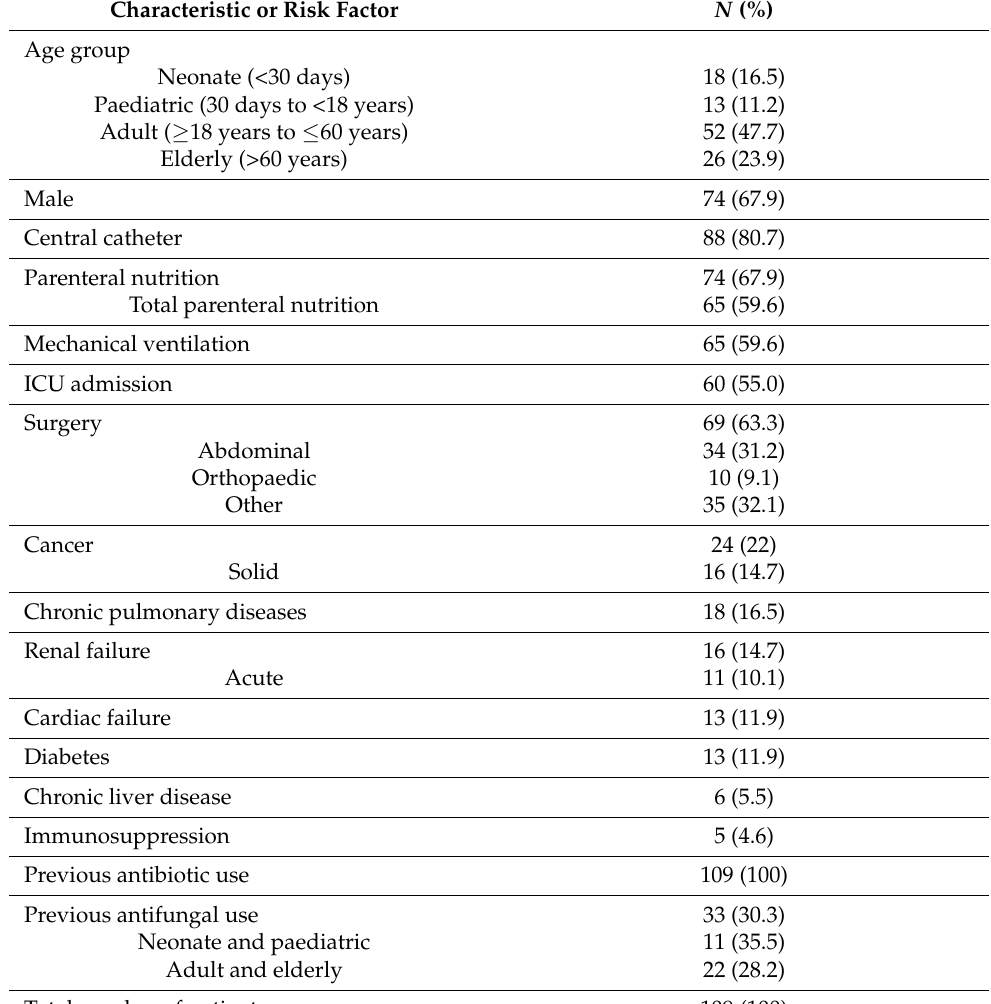
Table 1. Demographic data and identified risk factors among patients with